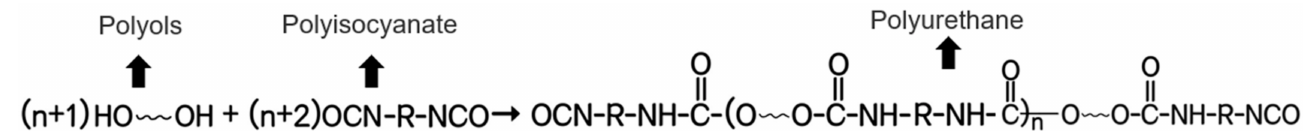
Figure 5. PU synthesis reaction